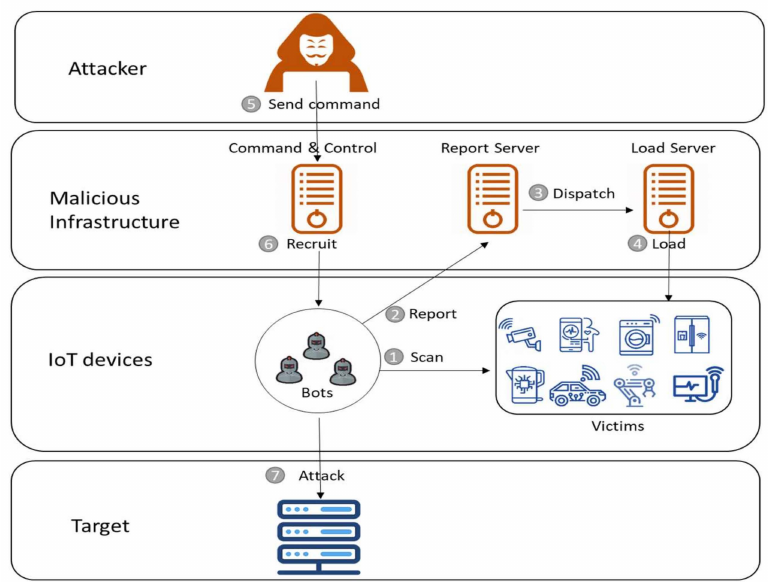
Figure 4. A flow diagram of an IoT